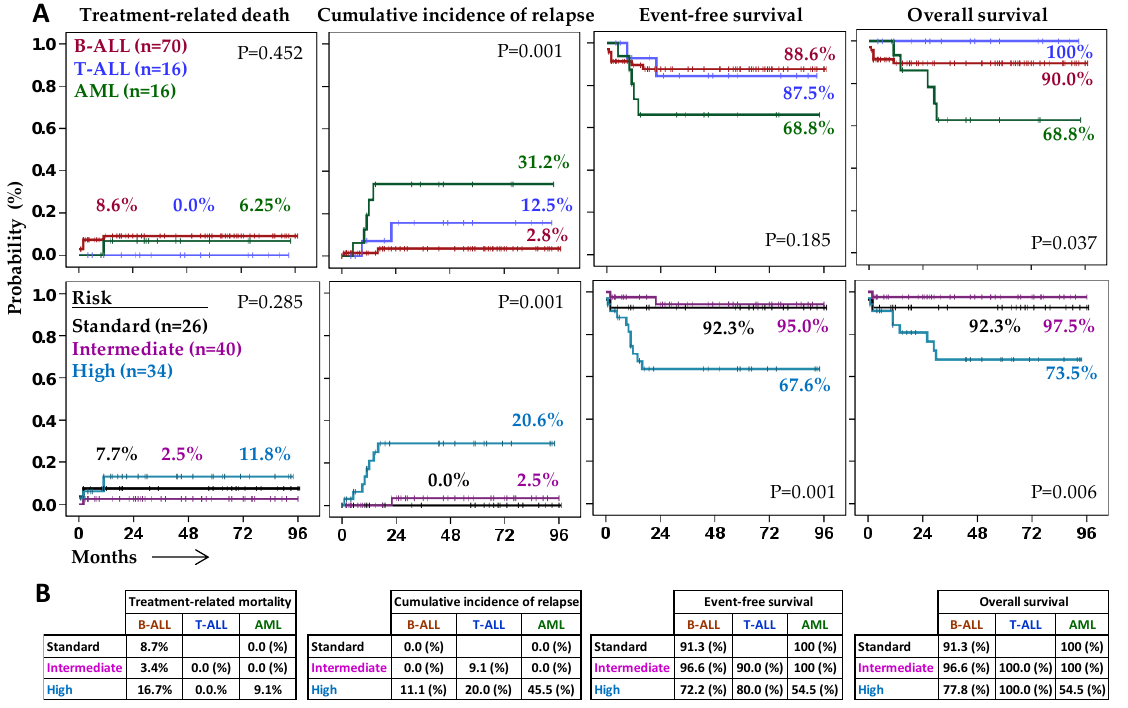
Figure 1. Patient outcome according to the type of acute leukemia and the risk status at enrollment. ( A ) Kaplan – Meier and log-rank tests for cumulative incidence of relapse, treatment-related mortality, event-free survival (EFS), and overall survival (OS) according to the type of acute leukemia (B-ALL, T-ALL, or AML) and the risk status at enrollment. ( B ) Rates (%) of cumulative incidence of relapse, treatment-related mortality, EFS, and OS according to the risk status of patients at diagnosis for each type of leukemia. Primary data can be consulted in File S1.